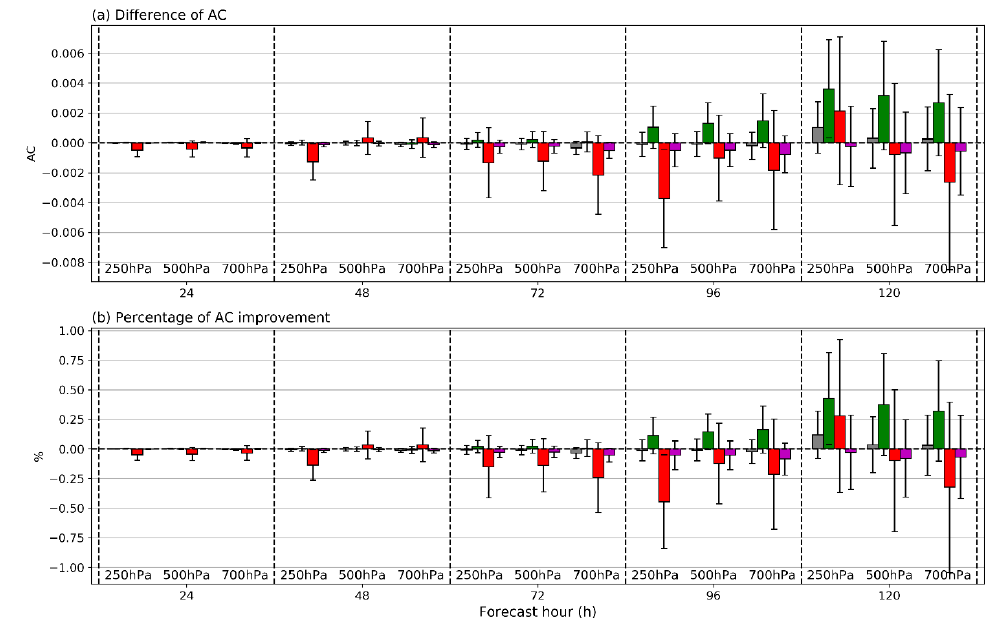
Figure 13. The ( a ) mean and ( b ) normalized difference of AC of 250 hPa, 500 hPa, and 700 hPa geopotential height forecast up to 120-h forecast hours between the latency_5m and latency_20m runs. Grey, green, red, and magenta boxes indicate the results over the Global, Northern Hemisphere, Tropic, and Southern Hemispheres, respectively. Vertical bars representing 95% confidence level of the uncertainty are overlaid.